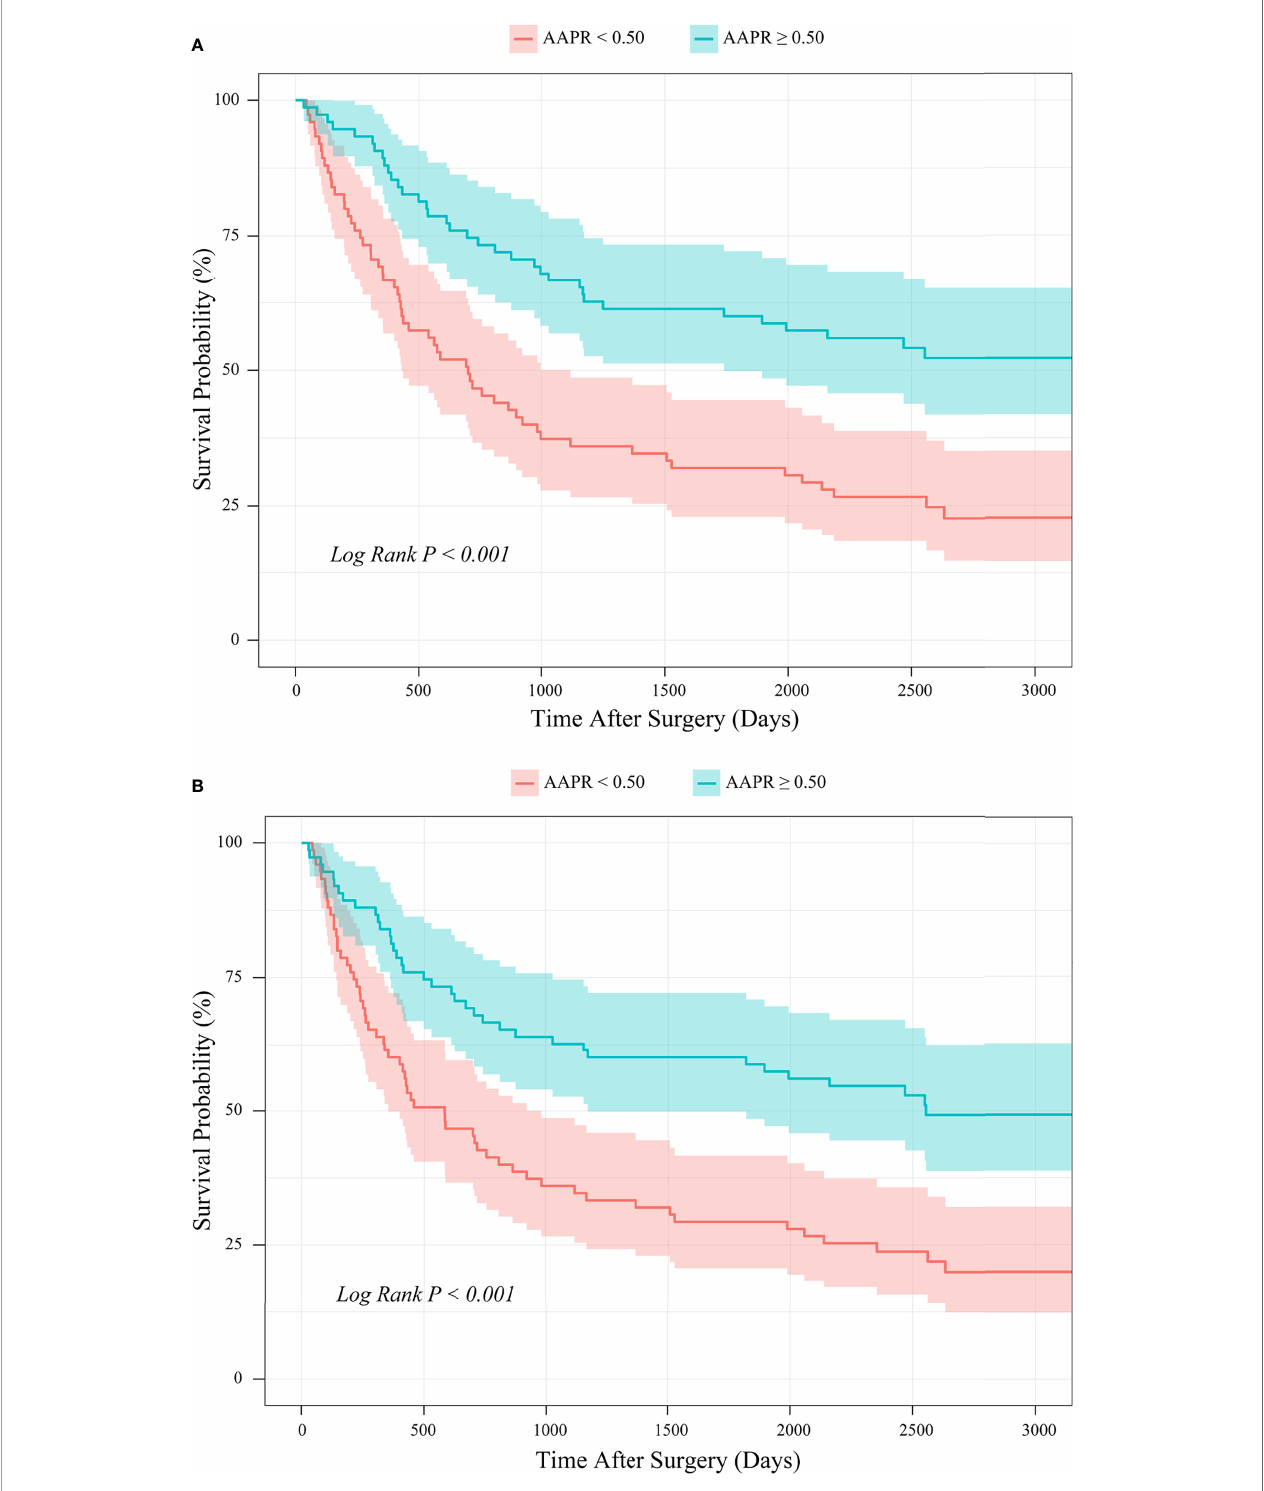
FIGURE 9 | PSM-based Kaplan-Meier survival analysis of (A) OS and (B) PFS between patient groups strati fi ed by preoperative